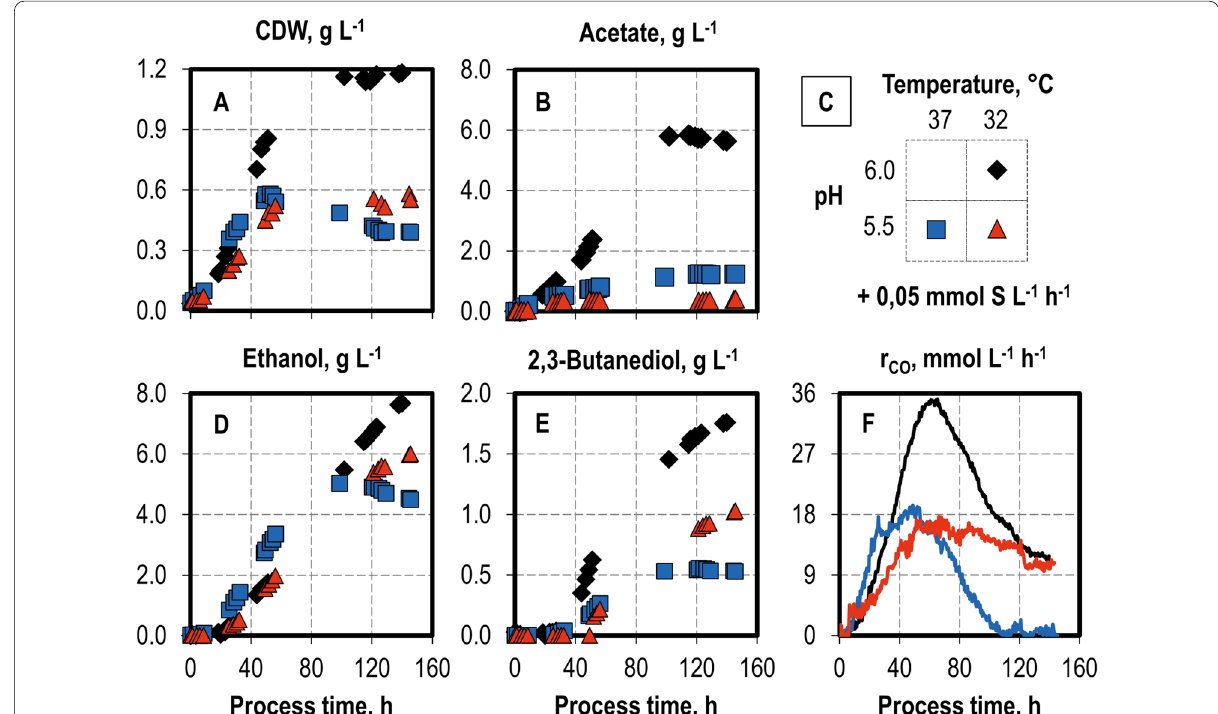
Fig. 5 Variation of pH profiles and temperatures in autotrophic sulfide fed‑batch processes with C. ragsdalei in a continuously gassed STR. Cell dry weight ( A CDW) and product concentrations ( B acetate; D ethanol; E 2,3‑butanediol) as well as CO uptake rates ( F r CO ). Parameter combinations are shown in C : pH 6.0 and 32 °C (black diamonds, black lines), pH 5.5 and 37 °C (blue squares, blue lines) and pH 5.5 and 32 °C (red triangles, red lines). The fed‑batch processes were operated at a Na 2 S 9 H 2 O feed rate of 0.05 mmol L − 1 h − 1 , working volume of 1 L, volumetric power input of 3.5 W L − 1 , gas flow rate of 5 NL h − 1 and an inlet partial pressure of 0.2 bar H 2 , 0.2 bar CO 2 , and 0.6 bar